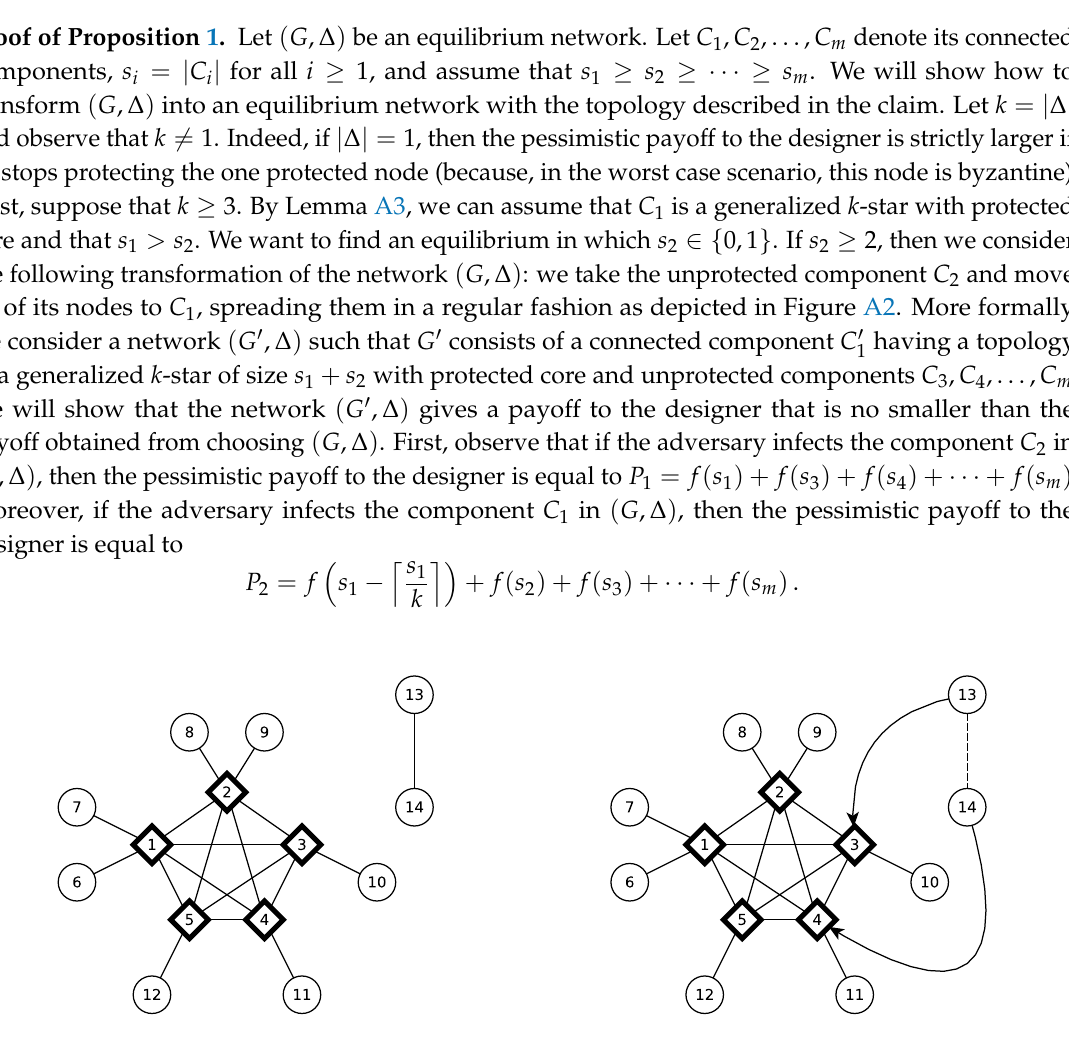
Figure A2. Spreading the nodes from an unprotected component to a core-protected generalized